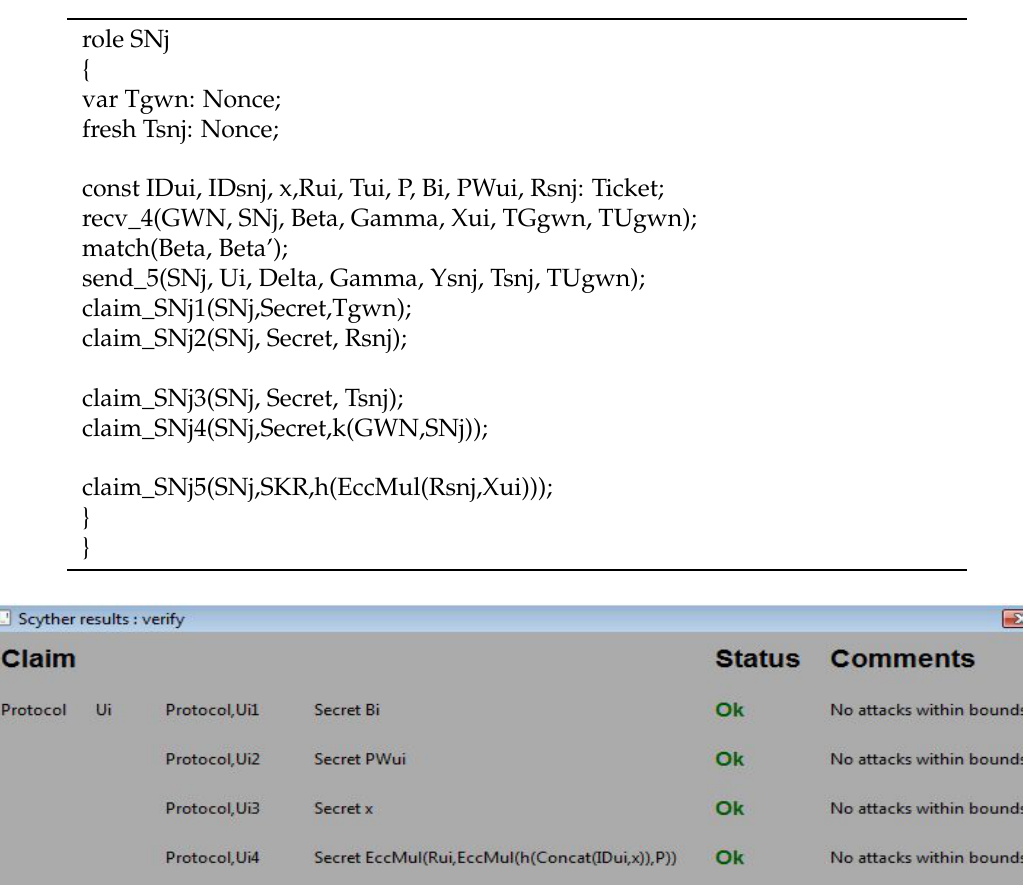
Table 13. Specification of the sensor’s role in SPDL.